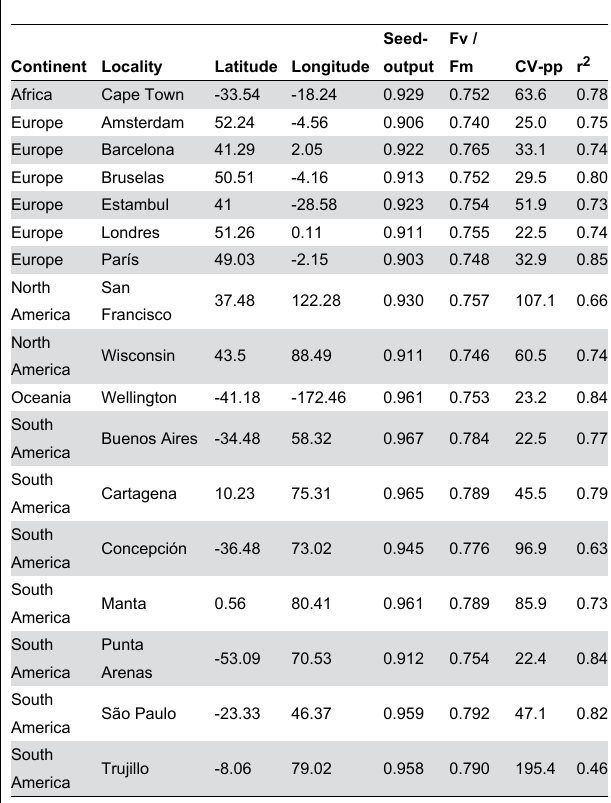
Table 1. Populations indicating the geographic coordinate where Taraxacum officinale seeds were